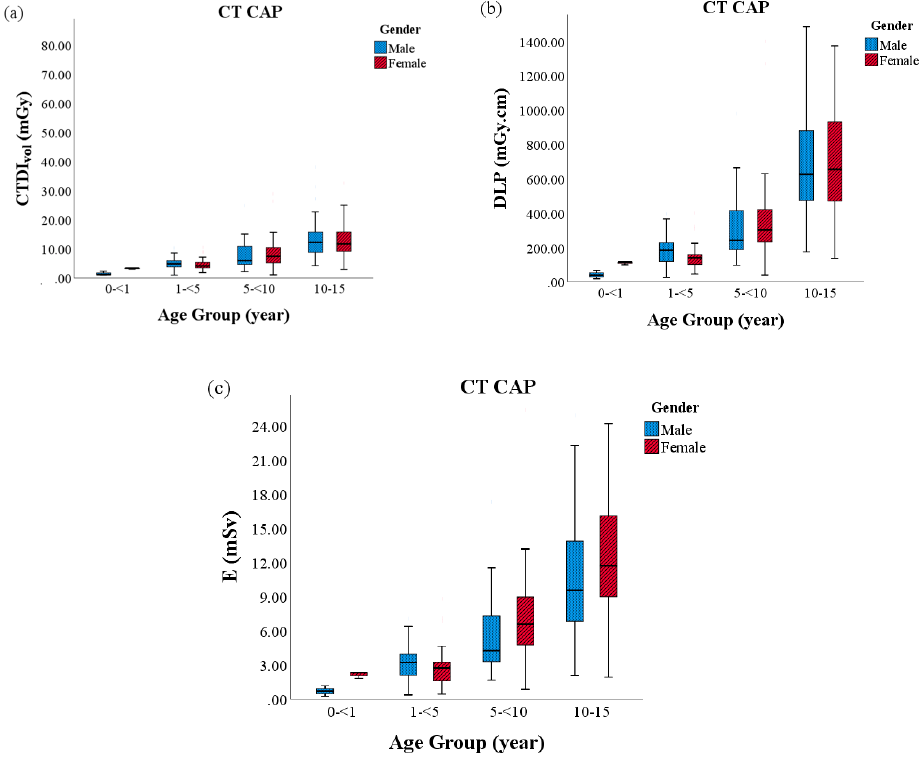
Figure 4. The radiation doses between sex and age in CT CAP: ( a ) volume computed tomography dose index (CTDIvol); ( b ) dose length product (DLP); and, ( c ) effective dose (E).